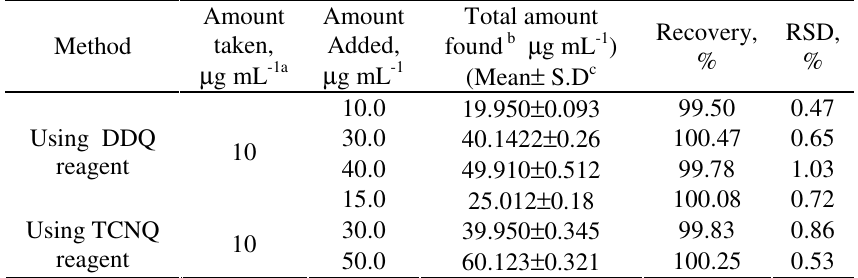
Table 2. Results of recovery studies by standard addition method